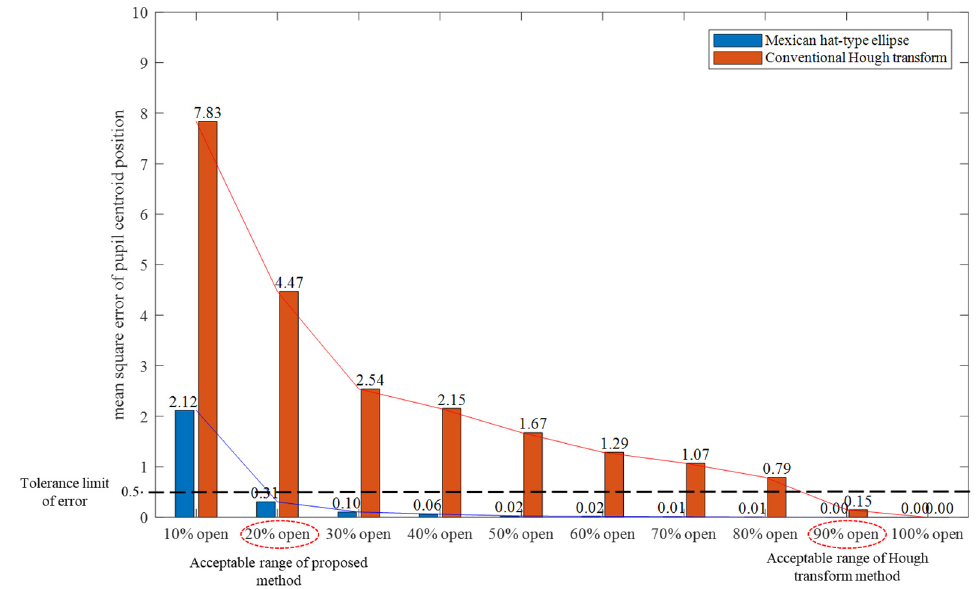
Figure 10. Comparison of MSE calculation results from the proposed Mexican hat-type ellipse pattern matching and the conventional Hough transform method.